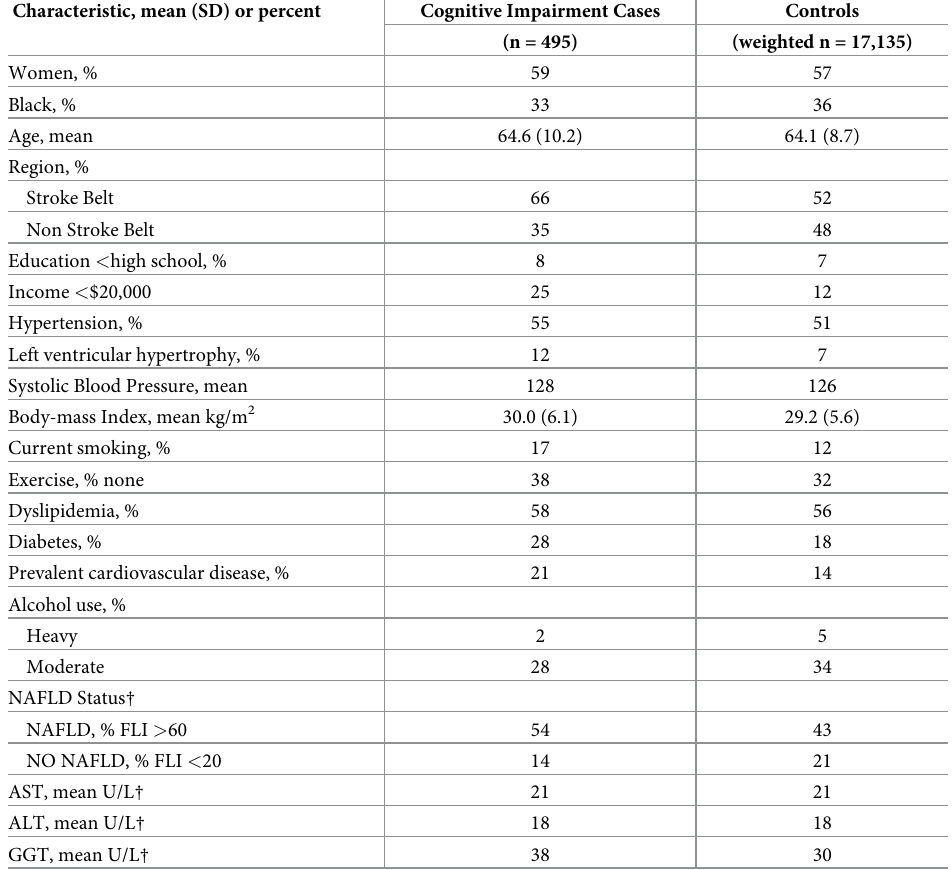
Table 2. Levels of risk factors, NAFLD, and liver biomarkers in incident cognitive impairment cases and controls. Characteristic, mean (SD) or percent Cognitive Impairment Cases Controls (n = 495)